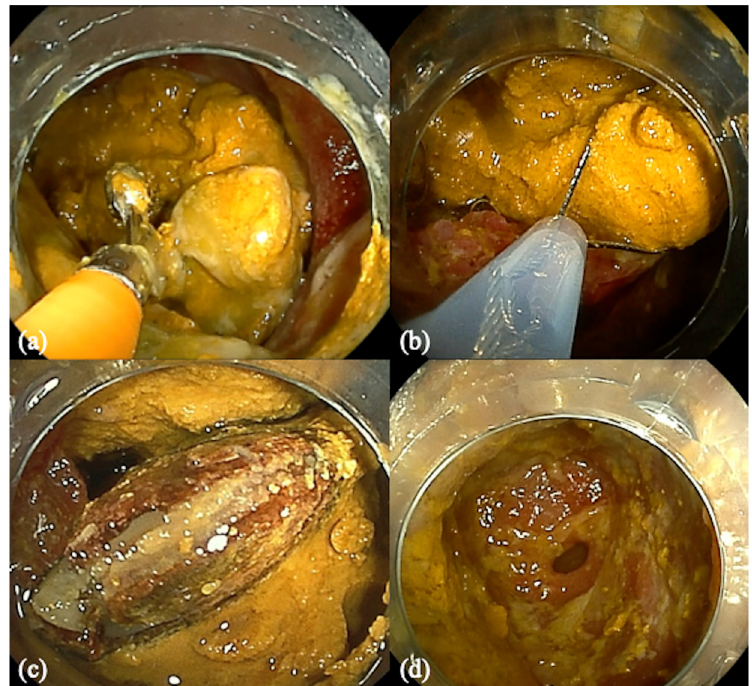
Figure 2. ( a ) We used forceps and ( b ) a snare in a tt empting to fracture the enterolith. ( c ) Seed in